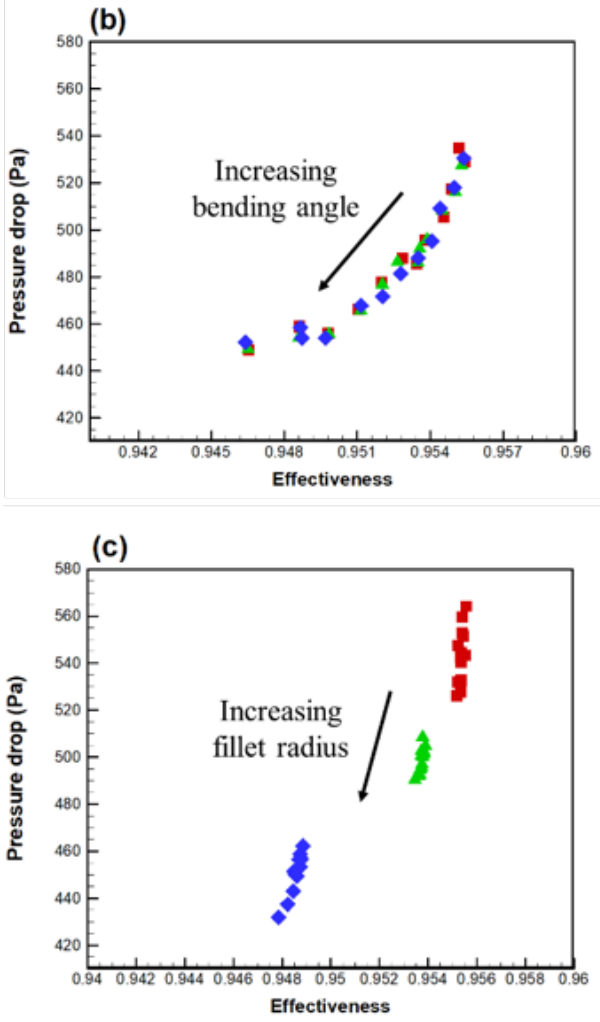
Figure 13. The variations of the pressure drop with the effectiveness at the three typical design points A’, B’, and C’ as marked in the Pareto optimal front (Figure 11) by adjusting ( a ) entrance length, ( b ) bending angle, and ( c ) fillet radius.